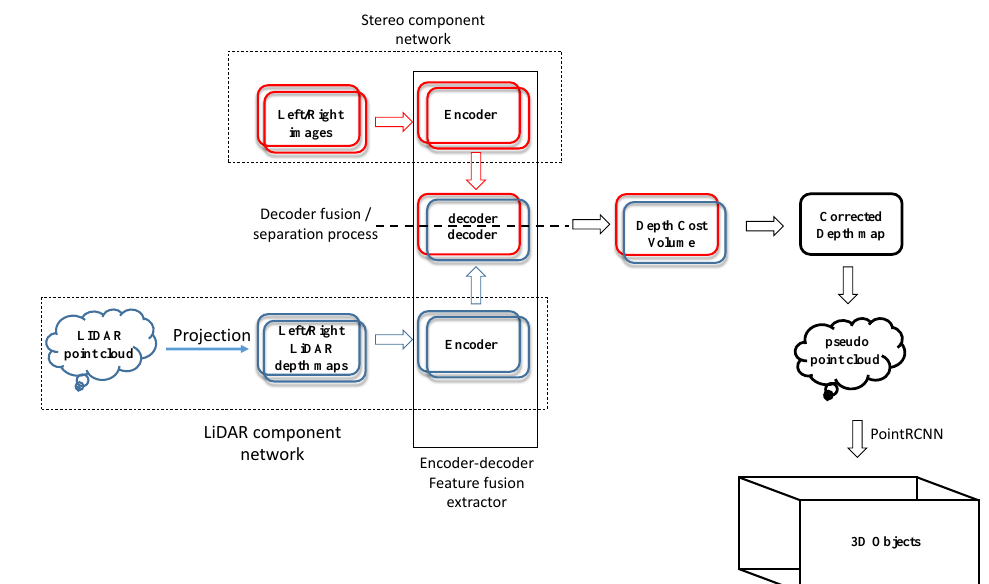
Figure 2. Overall structure of the SLS–Fusion neural network: red, blue, and red–blue boxes represent, respectively, stereo, LiDAR, and fusion networks: The LiDAR and stereo camera data are considered as inputs. Subsequently, in the encoder/decoder process, the resulting features are merged to obtain a depth map. Afterward, the depth map is converted into a point cloud, which makes it possible to estimate the depth of the objects detected by the two